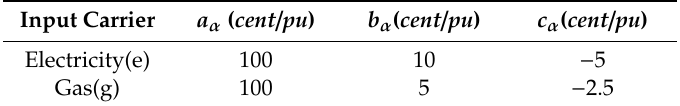
Figure 5. Simulated wind turbine production. Table 2. Assumed energy prices.